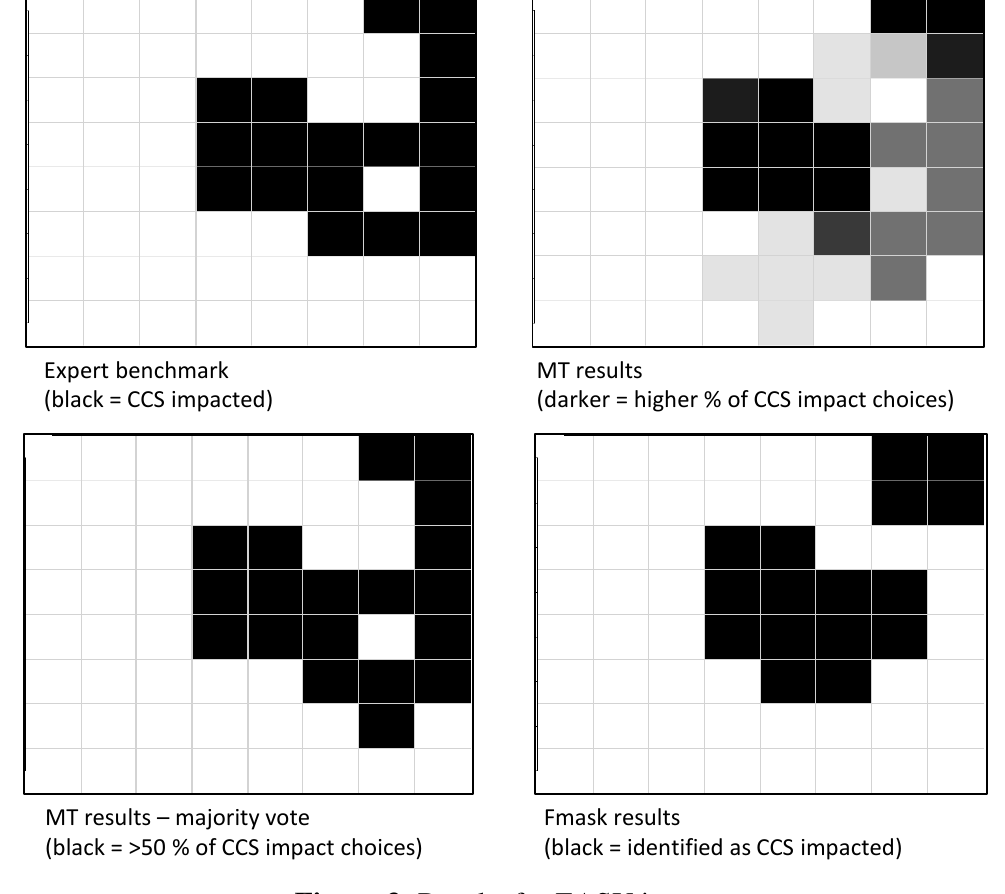
Figure 3. Results for EASY